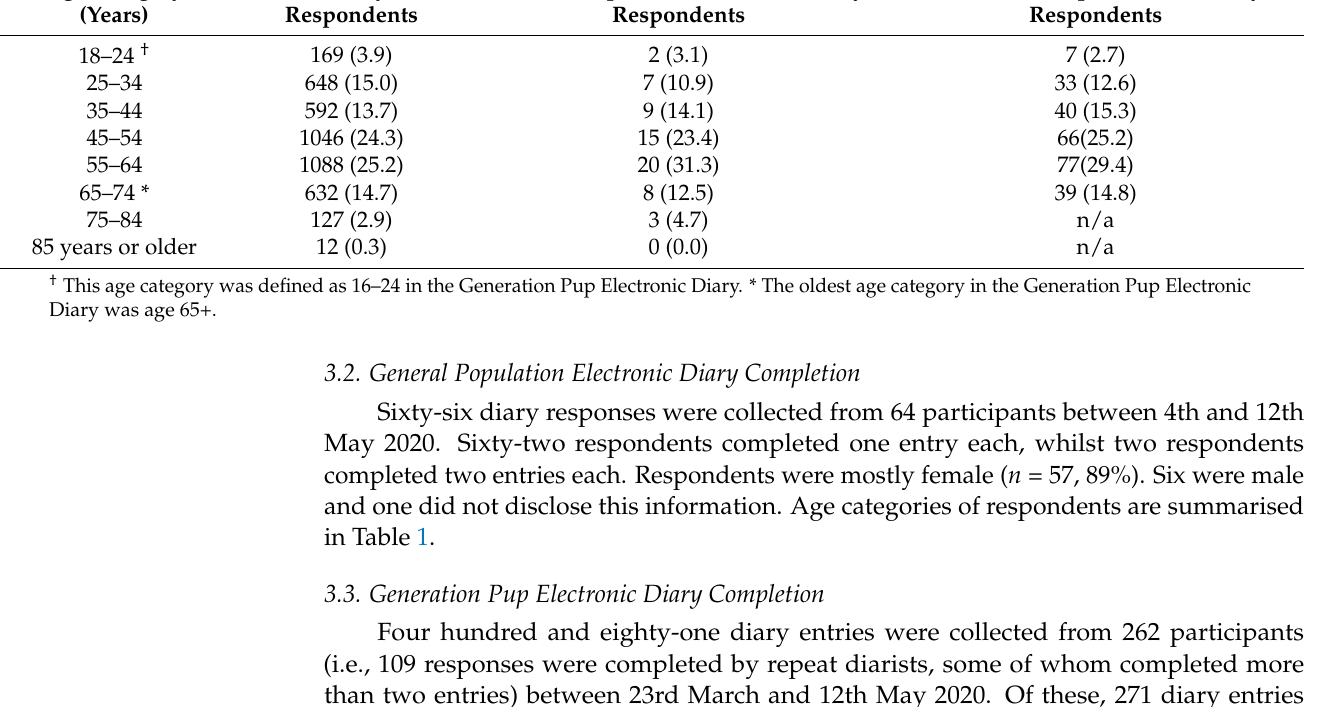
Table 1. Age of Survey, General Population Electronic Diary and Generation Pup Electronic Diary Respondents (n, %). Age Category